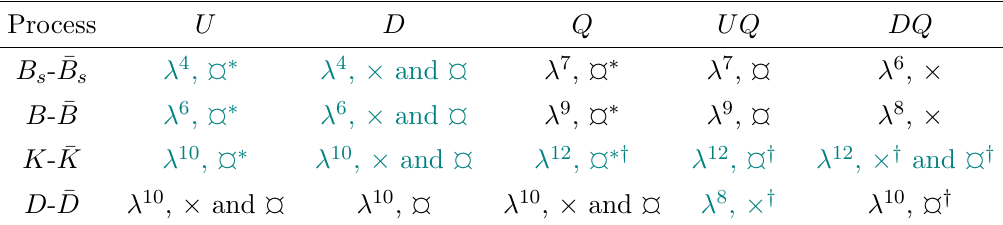
Table 2 . Structure of the contributions of the clockwork model to neutral-meson mixing, where the gears of a given type can appear alone (listed as U , D and Q ) or in pairs (listed as UQ and DQ ). In each entry we show the order in (cid:21) at which the contribution starts. We also indicate by the symbol \ " if the contributions is an ( v 4 =M 4 ) tree-level contribution and by the symbol \ ¤ " (cid:2) O if it is a ( v 2 =M 2 ) loop contribution. A \ " superscript in either of the two symbols further O y indicates that the given contribution receives a chiral enancement, and a \ * " superscript in the loop symbol indicates that the contribution is logarithmically enhanced. Entries in teal blue are the leading contributions taken into account in the numerical